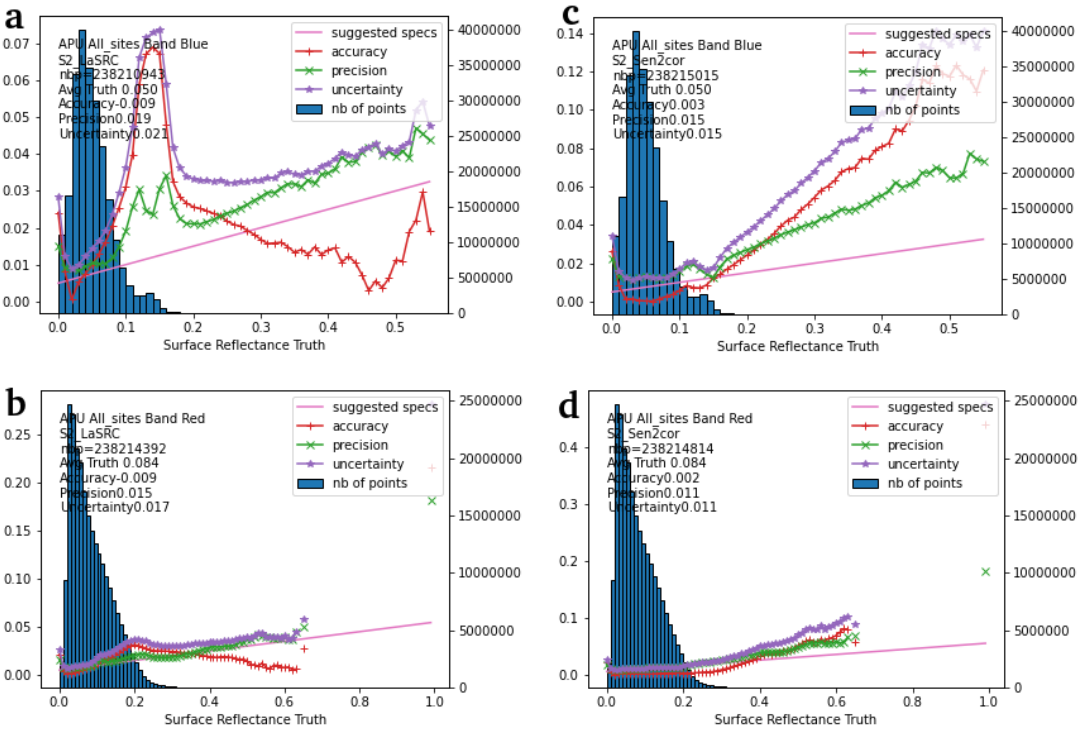
Table 3. Sentinel-2/MSI LaSRC surface accuracy (A), precision (P) and uncertainty (U) comparison between and reference data over all the sites.